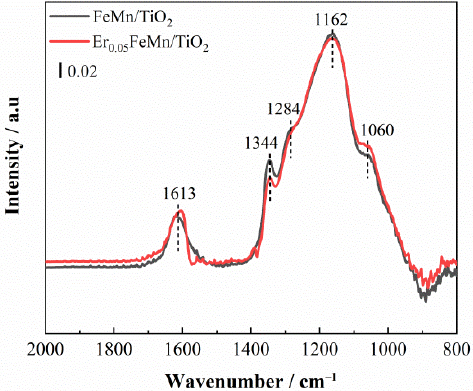
Figure 7. In-situ DRIFTS spectra of adsorption SO 2 over FeMn/TiO 2 and Er 0.05 FeMn/TiO 2 catalysts at 200 °C.